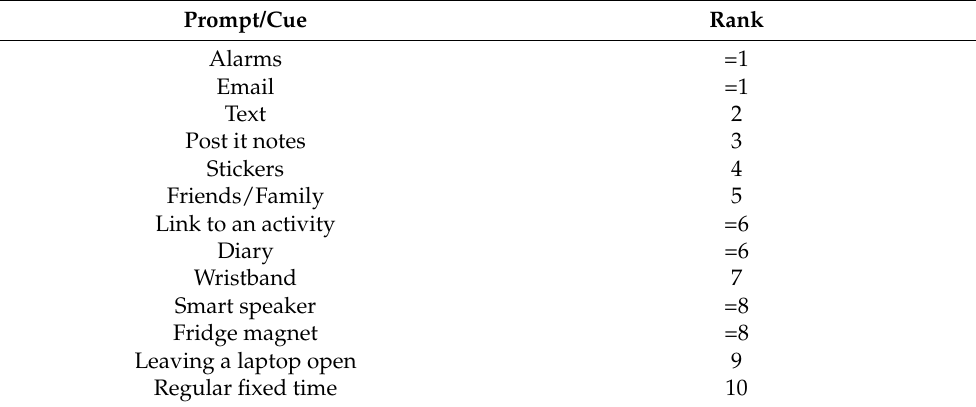
Table 3. Ranked preference of prompts and